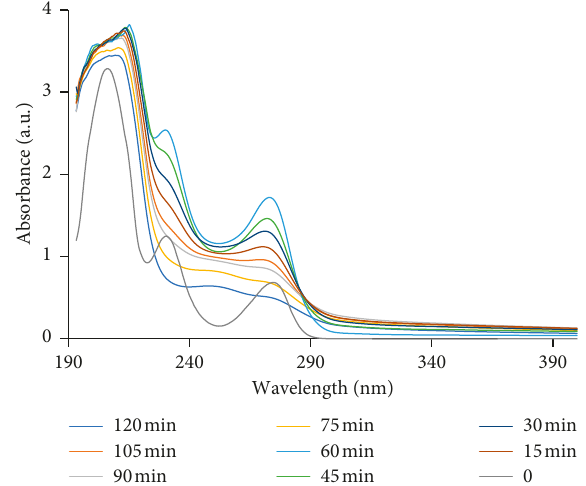
Figure 12: Fluorescence spectra of 2,4,6-trichlorophenol employed in the detection of superoxide radicals generated by the M2